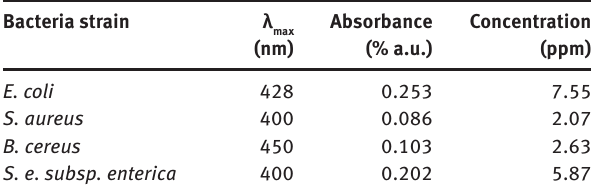
, absorbance and concentration of the fabricated Ag Table 2: λ max NPs using bacterial extracts.